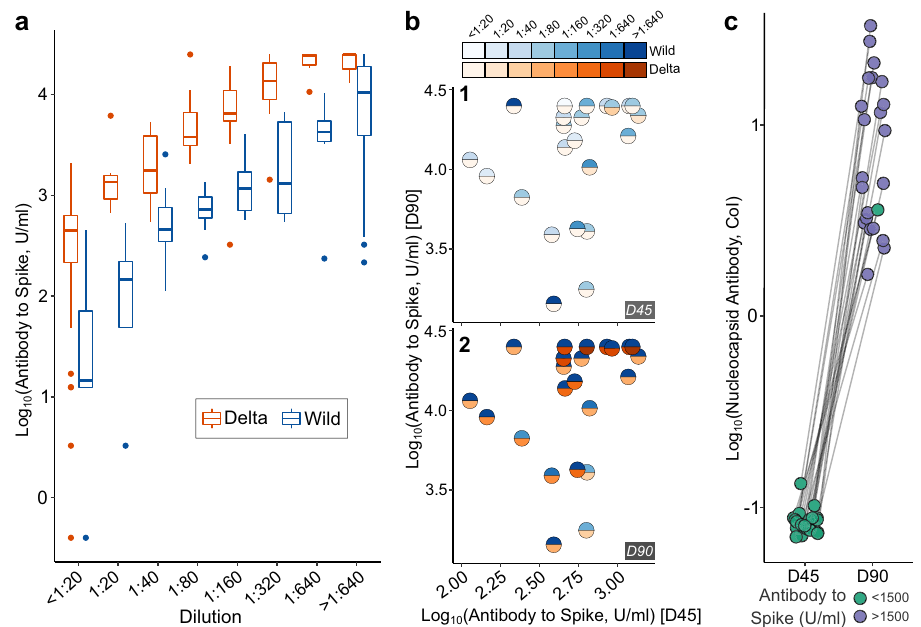
Fig. 2 Neutralization to Delta and Wild-type variant w.r.t antibody levels. a Box plot for Anti-S titers for similar neutralization titers against Wild type and Delta strain ( n = 111). Box plot is 25 – 75 range box, with median line. Whiskers are set at 1.5 * IQR. b MnT assay titer to the Wild strain and Delta strain response at day 45 (2b1) and 90 (2b2) for breakthrough cases ( n = 23, for 1 sample; q.n.s.). They show weak neutralization to both wild type and delta at D45 (before being infected) indicated through light shades in 2b1. However, post-infection at day 90, the same subjects show an increased ability of neutralization to delta strain (Fig. 2b2). c Anti-NC antibody response at D45 and D90 when comparing the rise in quantitative titers for breakthrough cases for same subjects in Fig. 2b ( n =